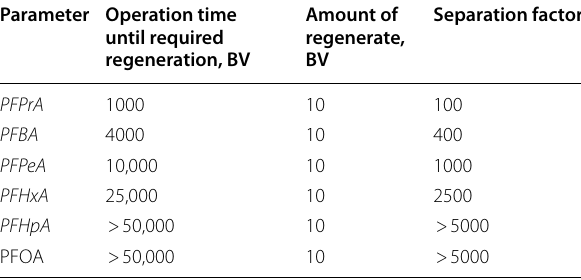
Table 7 Achievable separation factors if regeneration is carried out after the onset of breakthrough of the substance